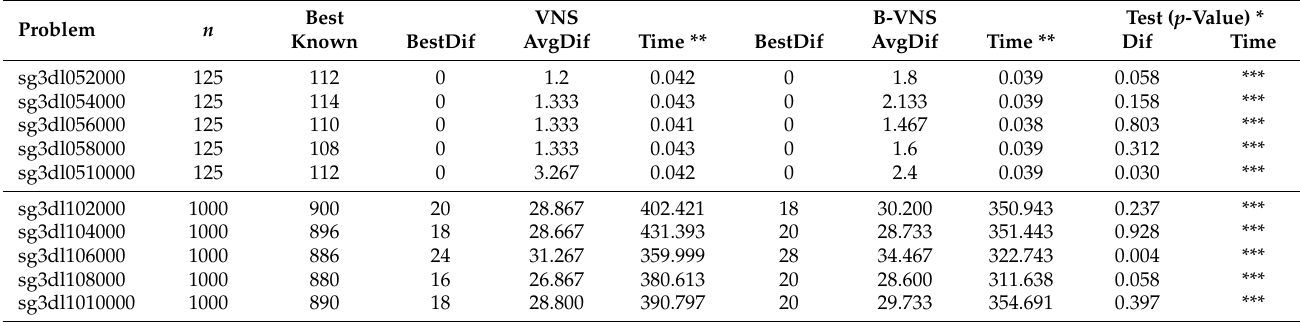
Table 4. Results for Burer et al. [41]